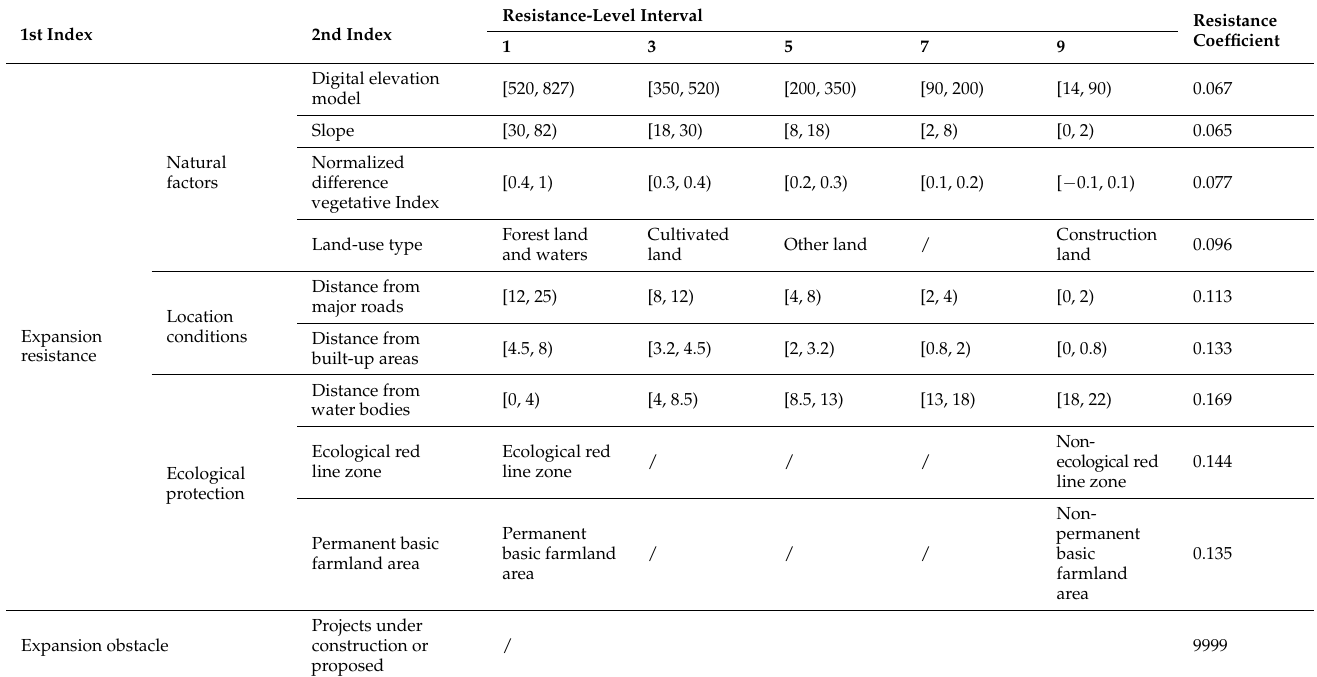
Table 2. Evaluation indexes of ecological resistance in the